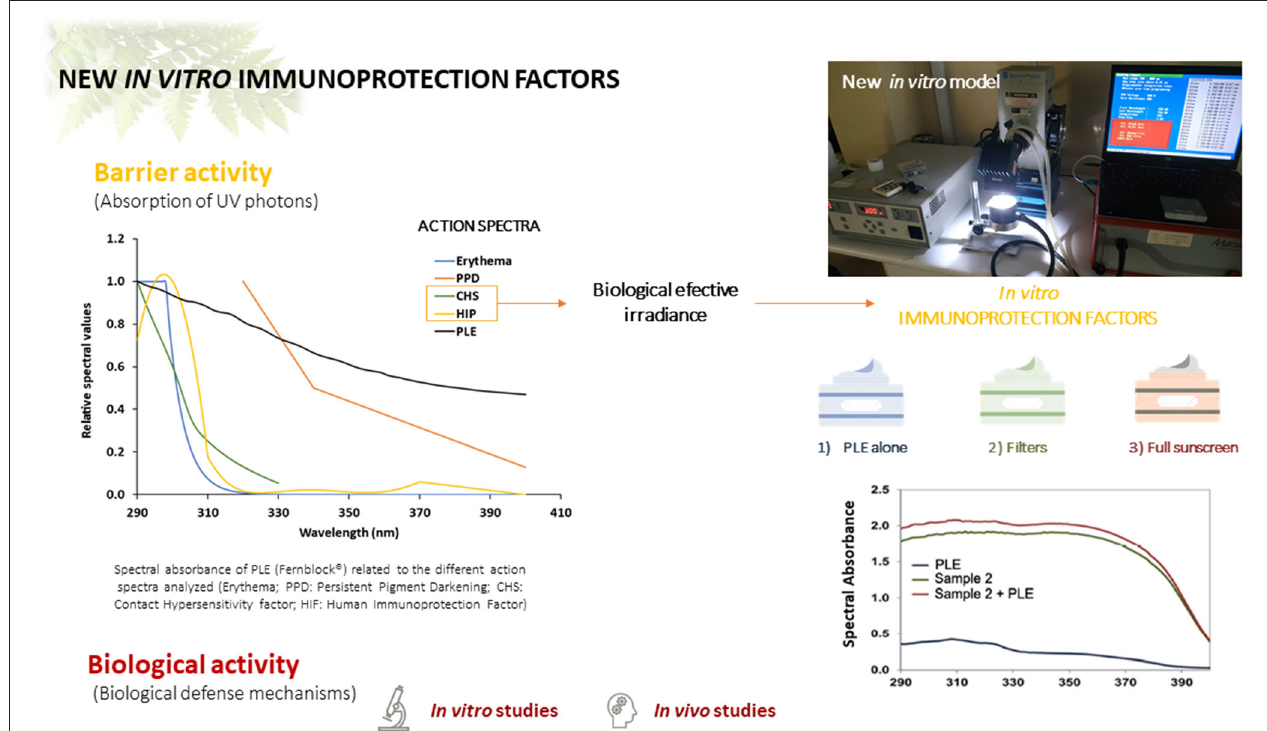
FIGURE 4 | Summary of the effect of PLE (Fernblock ® ) on diverse action spectra related to erythematous photoprotection and photoimmunoprotection. PLE is endowed with both types of activity when incorporated to canonical sunscreen